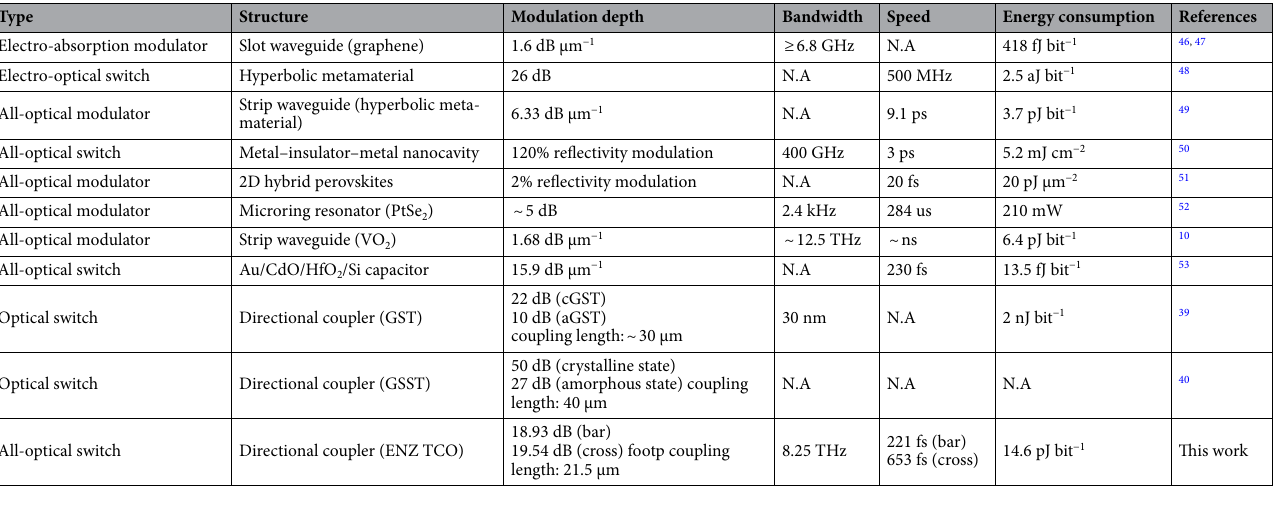
Table 1. Performance comparison with recent